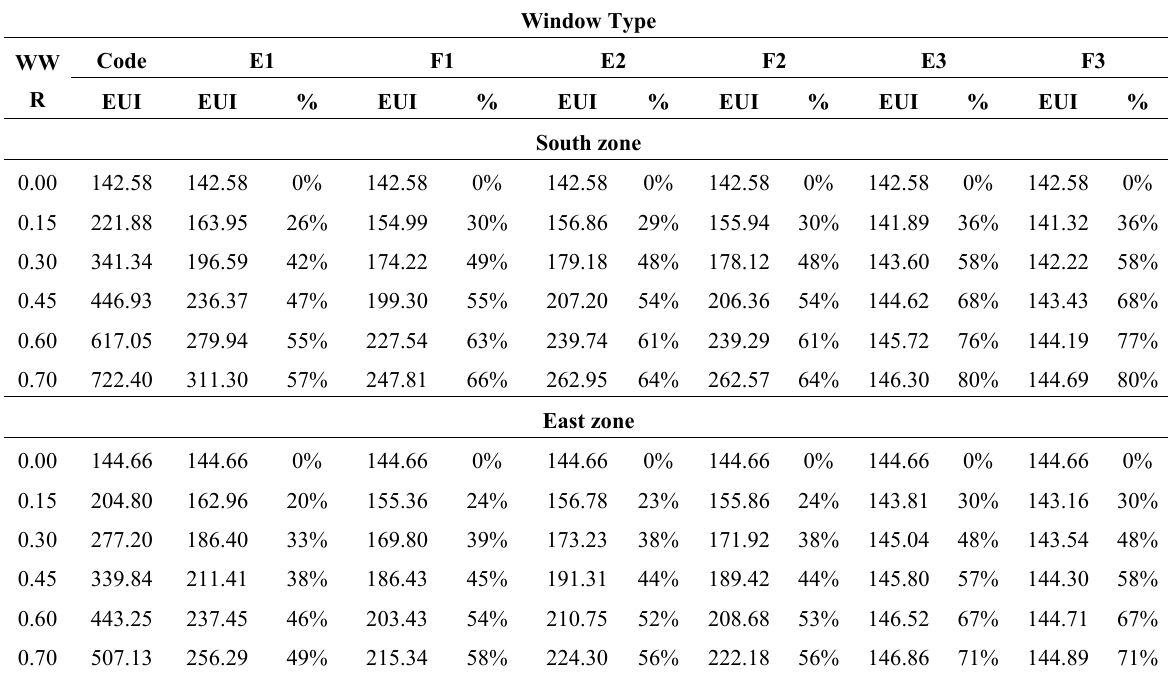
Table 8. HVAC electricity energy use intensity (EUI, MJ/m 2 -year) and percent savings compared to the GB 50189-2005 Standard for